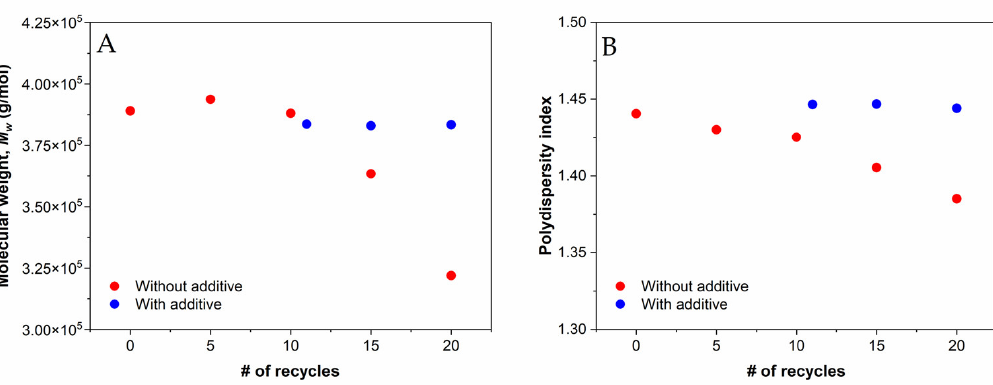
Figure 8. ( A ) Molecular weight distribution and ( B ) polydispersity of virgin PP, recycled PP without and with additive, respectively.